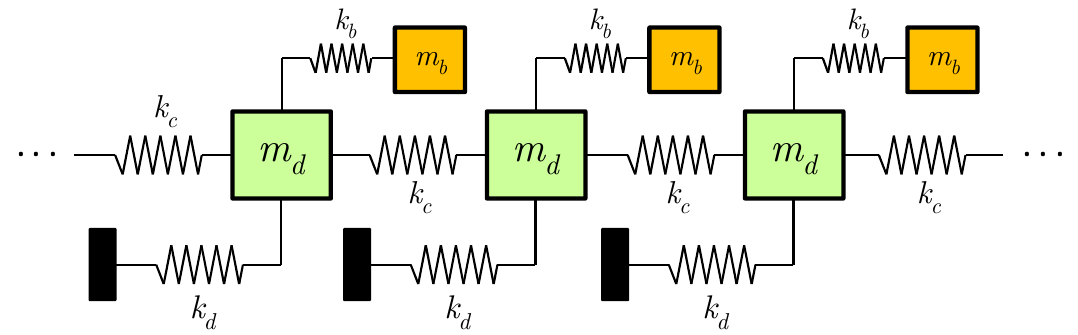
Figure 3. Lumped parameter model of a bladed disk assembly used for